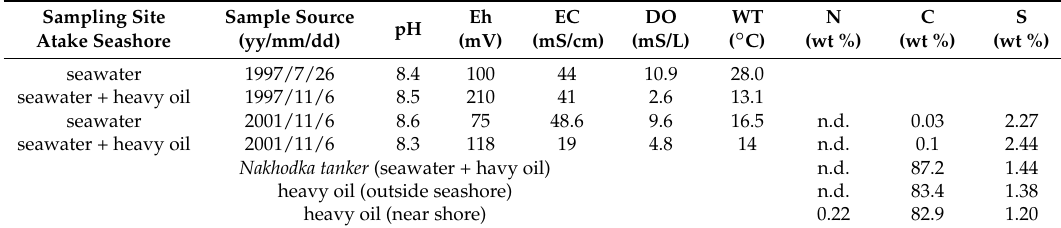
Table A4. Physical characteristics of seawater at Atake seashore. These parameters were measured in November 2001 [13].